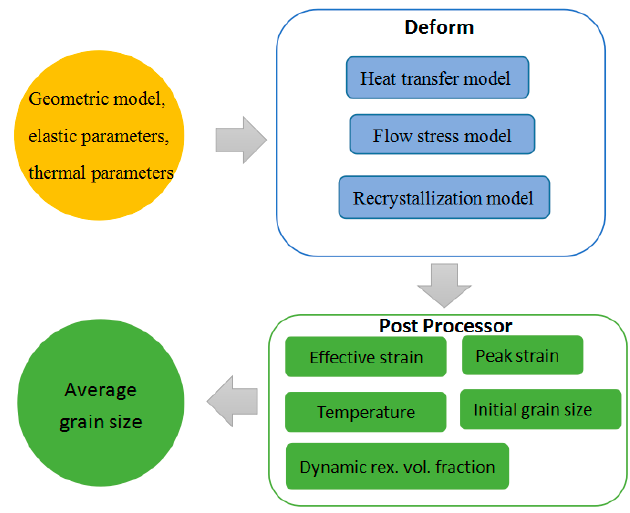
Figure 1. Deform modeling process.